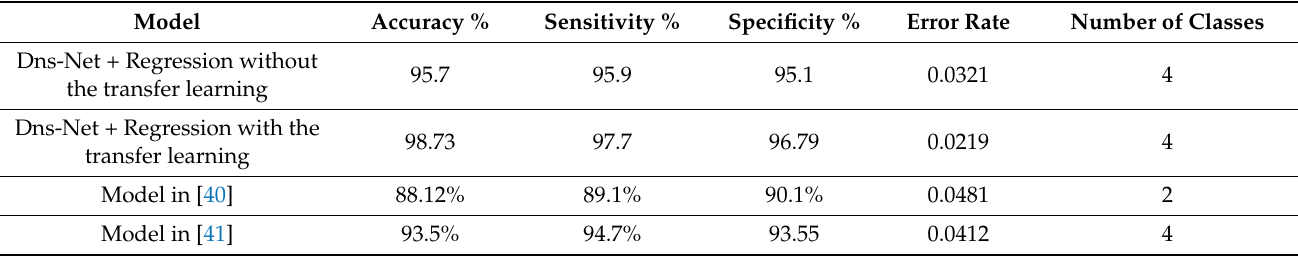
Table 7. Experimental Results for